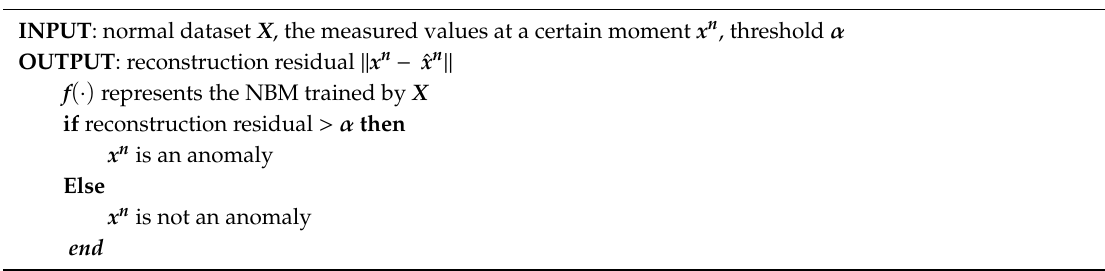
Algorithm 1 Anomaly detection using the NBM